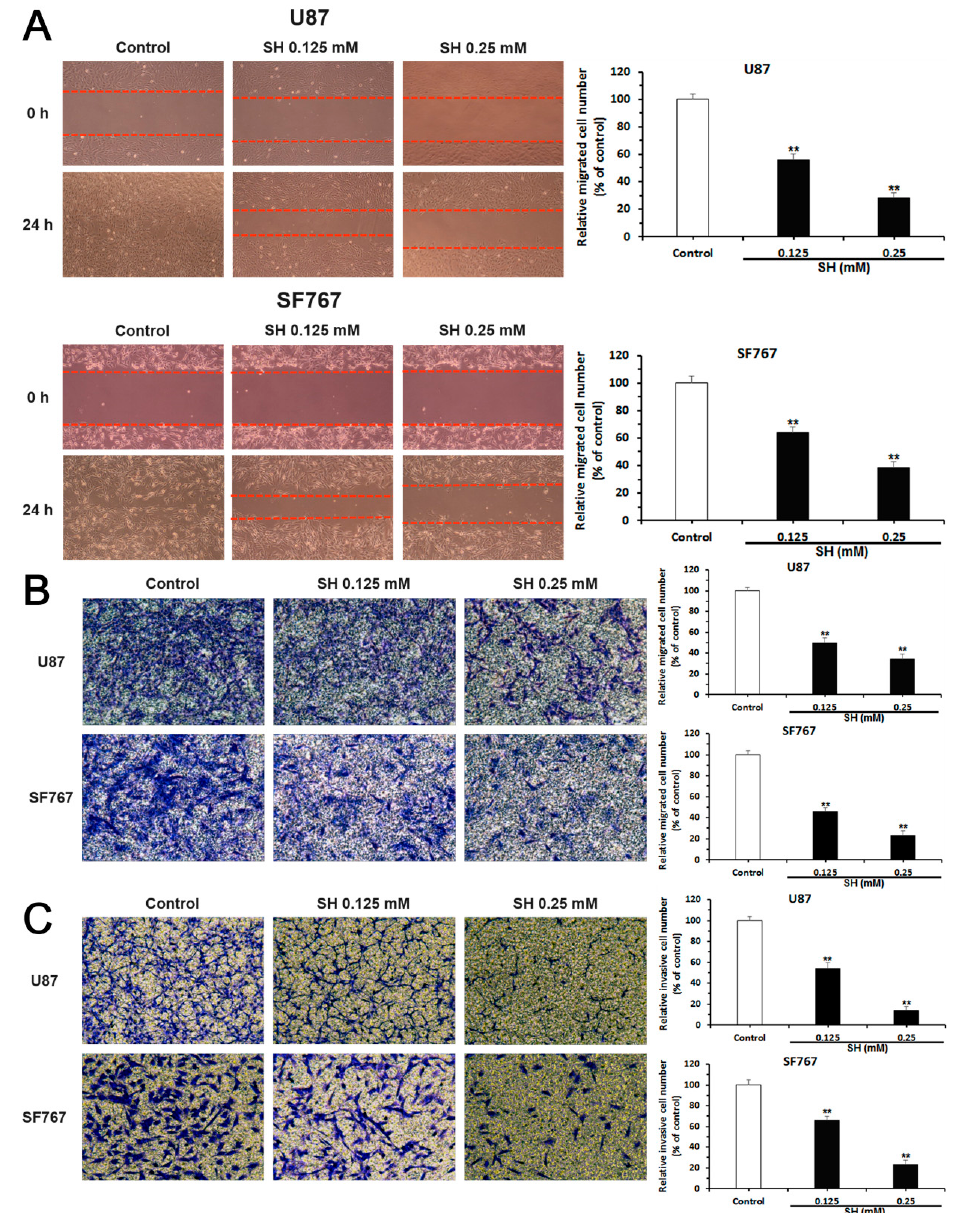
Figure 2. Effects of SH on the migration and invasion of human glioblastoma cells in vitro. U87 and SF767 cells were treated with SH (0.125, 0.25 mM) for 24 h. ( A ) Results and statistical analysis of wound healing assays for U87 and SF767 cells. The red dotted lines represent the locations of cell migration to the wounded area; ( B ) Results and statistical analysis of Transwell migration assays for U87 and SF767 cells; and ( C ) results and statistical analysis of matrigel-coated Transwell invasion assays for U87 and SF767 cells. All images were captured at 100× magnification. Each image is representative of n = 3 experiments. All data are presented as means ± SEM, n = 3. ** p < 0.01 compared with the control.